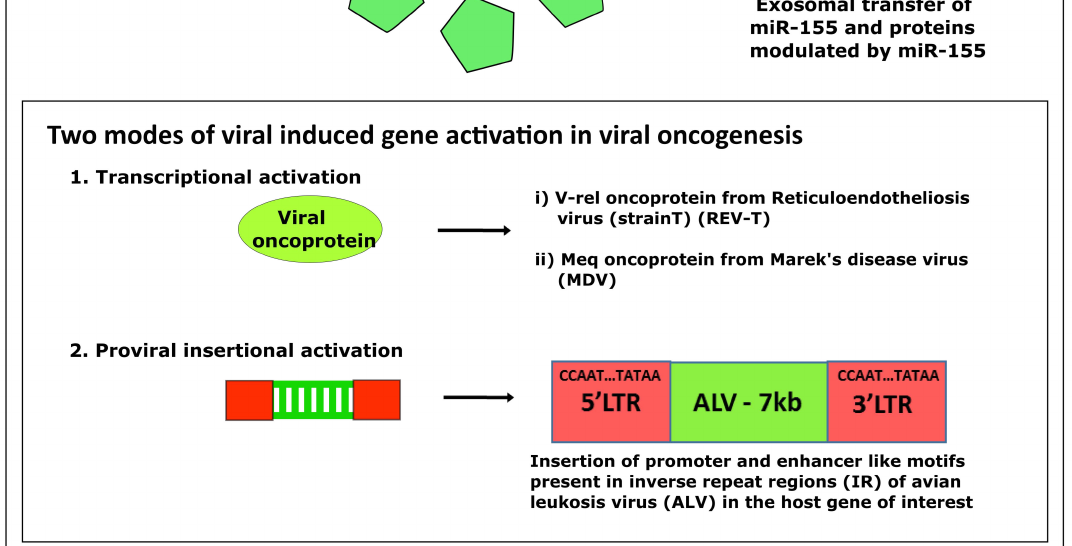
Figure 1. Molecular mechanisms of transformation by oncogenic viruses through miR-155 pathways. Induction of miR-155 through proviral insertional activation or through virus-encoded/transduced oncoproteins such as v- myc , v- rel , and Meq results in the modulation of expression of a number of miR-155 target proteins, contributing to the neoplastic transformation of the infected cell. Exosomal transfer of miR-155 and other proteins from the transformed cells can also contribute to the transformation of adjacent new